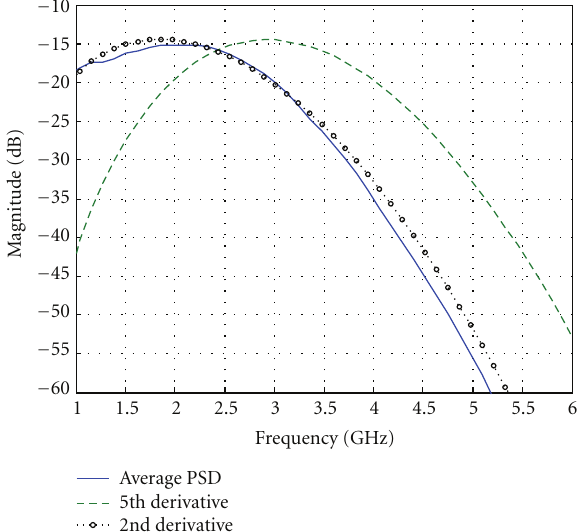
Figure 3: PSD of the transmitted Gaussian pulse (fifth derivative), the averaged PSD of the in-body channel, and the second derivative Gaussian pulse signal fitted to the average